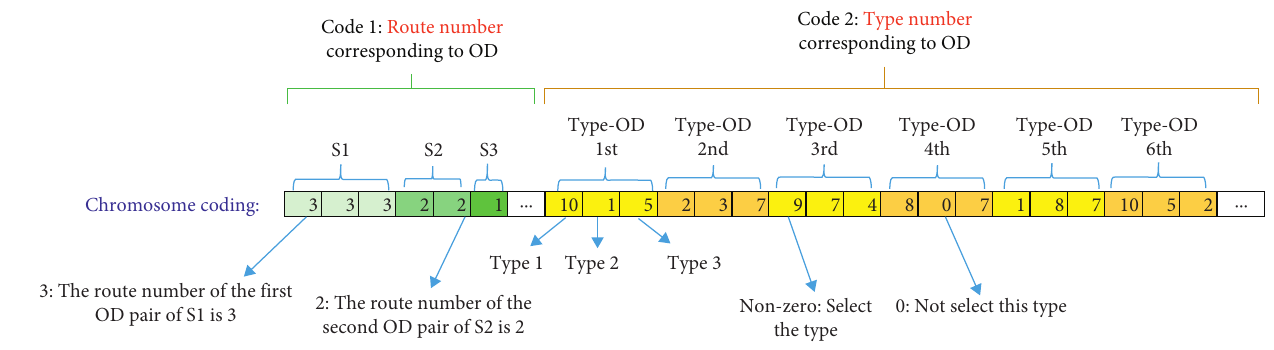
Figure 4: Double-layer coding analysis.